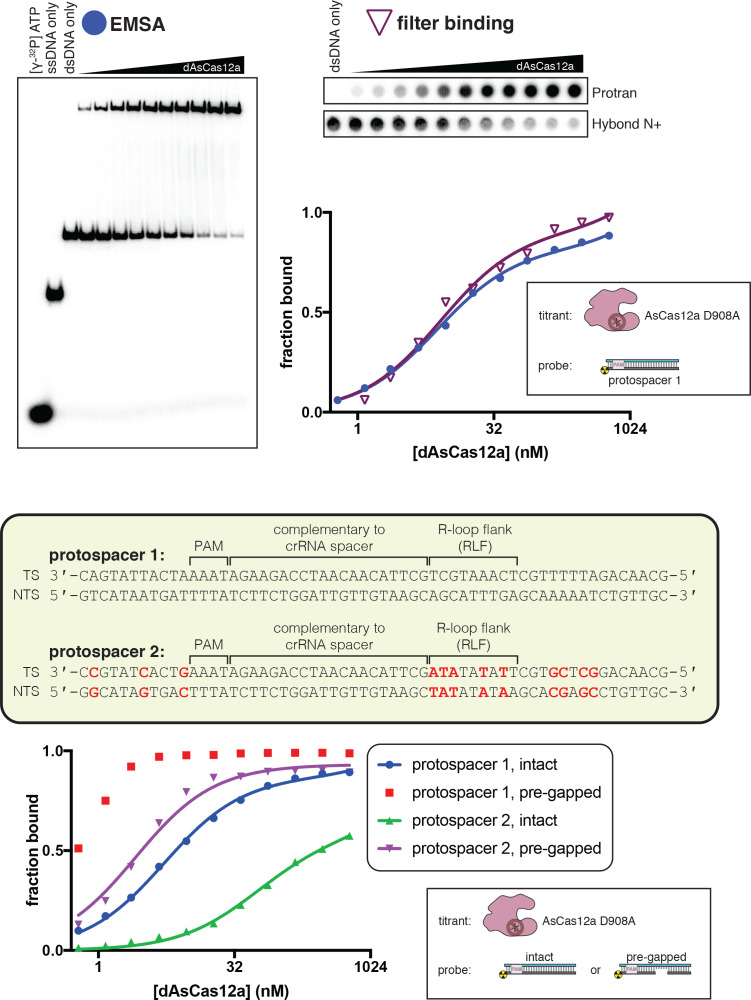
A gap in the non-target strand increases the affinity of dCas12a for its DNA target.Top panel: The affinity of dAsCas12a/crRNA for a cognate DNA target was assessed by an electrophoretic mobility shift assay (EMSA) and a filter-binding (FB) assay. dAsCas12a was titrated in a solution with fixed [crRNA] (750 nM) and [DNA probe] (100 pM), followed by separation of protein-bound DNA from free DNA. The EMSA indicated that the oligonucleotide annealing protocol yields 100% duplex DNA probe and that the binding conditions yield one major protein-bound species. ‘Fraction bound’ is defined as (background-subtracted volume of upper band)/(total background-subtracted lane volume) for the EMSA and (background-subtracted volume of Protran spot)/(total background-subtracted volume of Protran spot + Hybond N+ spot) for the filter-binding assay. The value of ‘fraction bound’ was 0 at [dAsCas12a]=0 for both assays (not shown in plot due to the logarithmic x-axis). When appropriate, data were fit to the sum of a hyperbola and a line (y = Bmax*x/(KD+x)+NS*x), where NS describes a non-specific binding mode. It is common to see Bmax values below 1 in EMSAs and filter-binding assays, in which the process of physical separation can disrupt bound species. KD for the EMSA was 8.2 nM (n = 1). KD for the filter-binding assay was 8.1 nM ±0.8 (SD) (n = 3). Bottom panel: Using the filter binding assay, we assessed the affinity of dAsCas12a/crRNA for various cognate DNA targets. Protospacer 2 (used in Figure 2B) is the version of protospacer 1 (used in Figure 2A) modified for permanganate probing of the R-loop flank. Differences between protospacer 1 and protospacer 2 are highlighted in red (A/T base pairs substituted into the R-loop flank, G/C base pairs substituted elsewhere to maintain stable association between the two DNA strands). ‘Intact’ protospacers are as shown in the sequence schematic. ‘Pre-gapped’ protospacers are missing nt 14–18 of the NTS (as measured from the PAM, see Appendix 2). The value of ‘fraction bound’ was 0 at [dAsCas12a]=0 for all substrates (not shown due to the logarithmic x-axis). Data were analyzed as described for the top panel. KD for protospacer 1 (intact) was 5 nM ±1 (SD) (n = 3). KD for protospacer 2 (intact) was 54 nM ±12 (SD) (n = 3). KD for protospacer 2 (pre-gapped) was 2.8 nM ±0.5 (SD) (n = 3). Data from the protospacer 1 (pre-gapped) experiment indicated that the KD was near or below [DNA probe], preventing accurate KD determination by hyperbolic fitting. The reason for the low observed affinity of dAsCas12a for protospacer 2 (intact) is unknown.